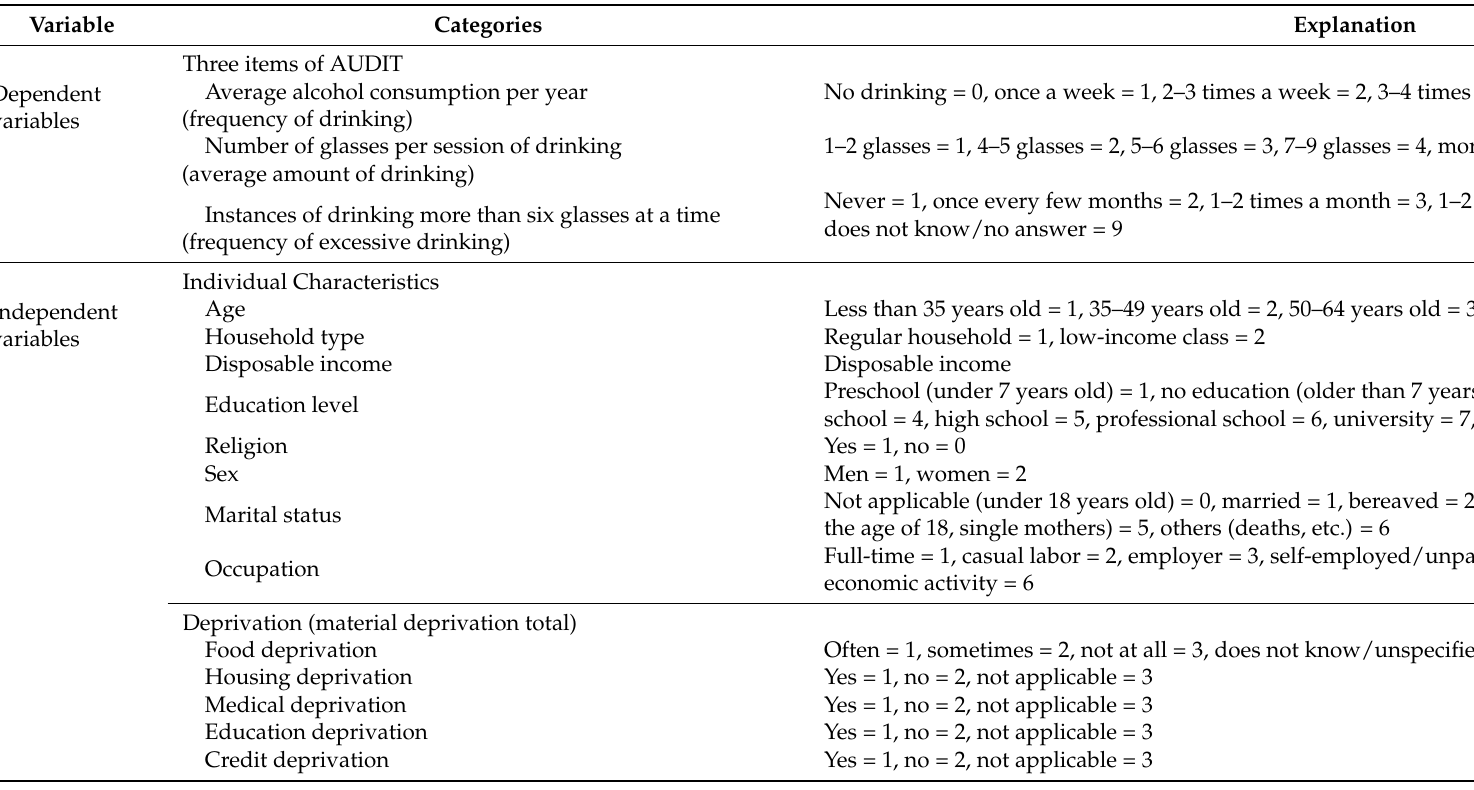
Table 1. Composition of